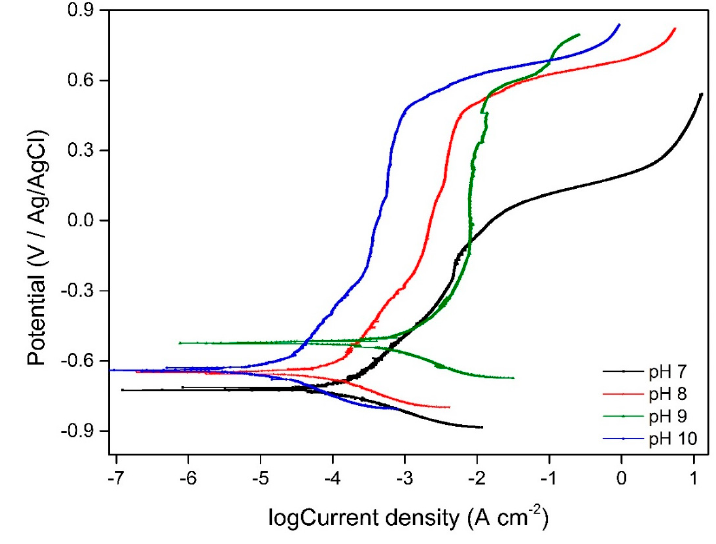
Figure 8. Change in double layer capacitance during exposure time of working electrodes in different pH environments.